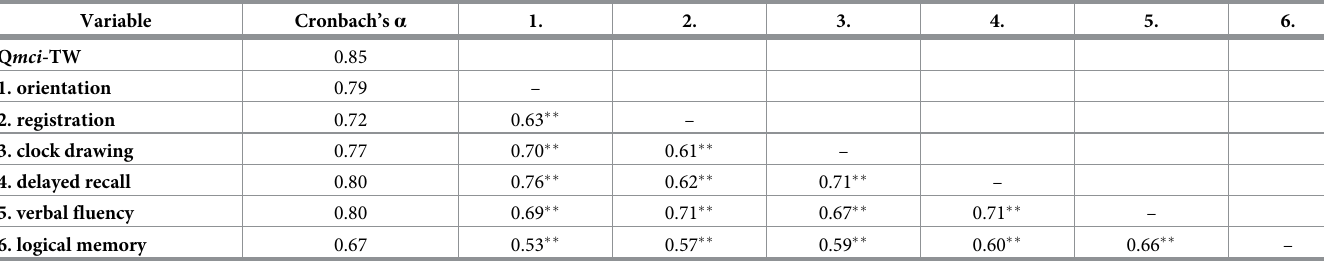
Table 5. Results of internal consistency and the inter-item correlation of the Q mci -TW.